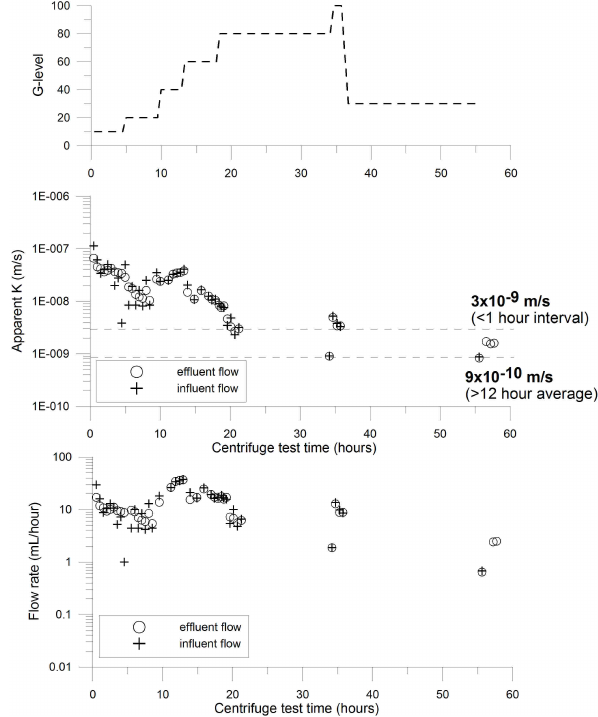
Figure 3. Centrifuge permeameter testing at low stresses of a semi- consolidated clayey-silt core sample (CL 26.1m depth; Test 39-1) showing variation of g level, K v , and influent and effluent flow rate during the test (after Timms et al.,